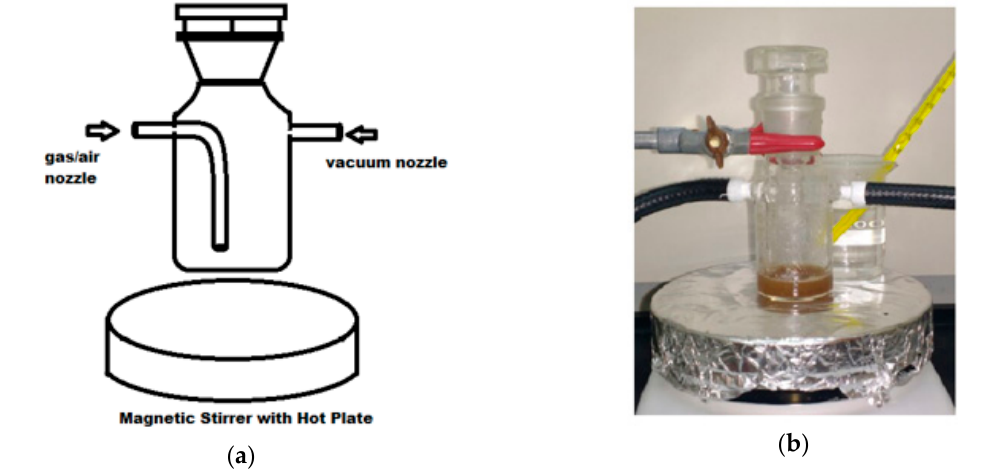
Figure 2. Vacuum glass reactor made for inert atmosphere dissolution and hydrolysis of BHKP using ILs: ( a ) Schematic representation of the main components; ( b ) Photograph of the laboratory reactor.